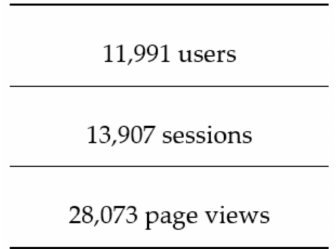
Figure 7. Summary of Arsenic and You website analytics. Data comes from Maccini 2018